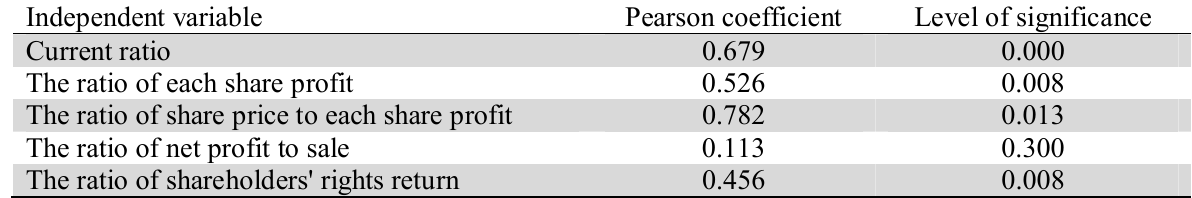
The correlation coefficient between independent variables and systematic risk